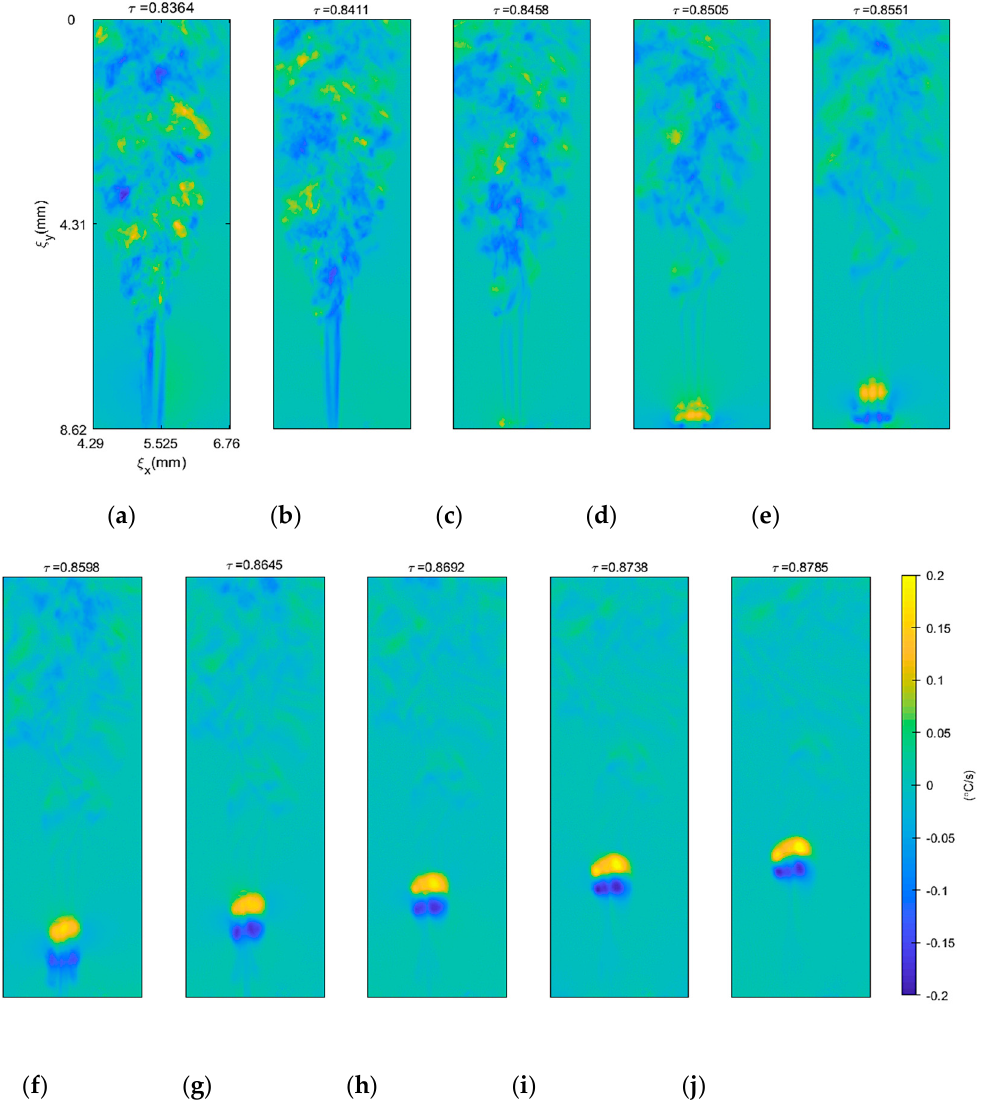
Figure 9. ( a–j ) Temporal finite difference temperature for different instants.